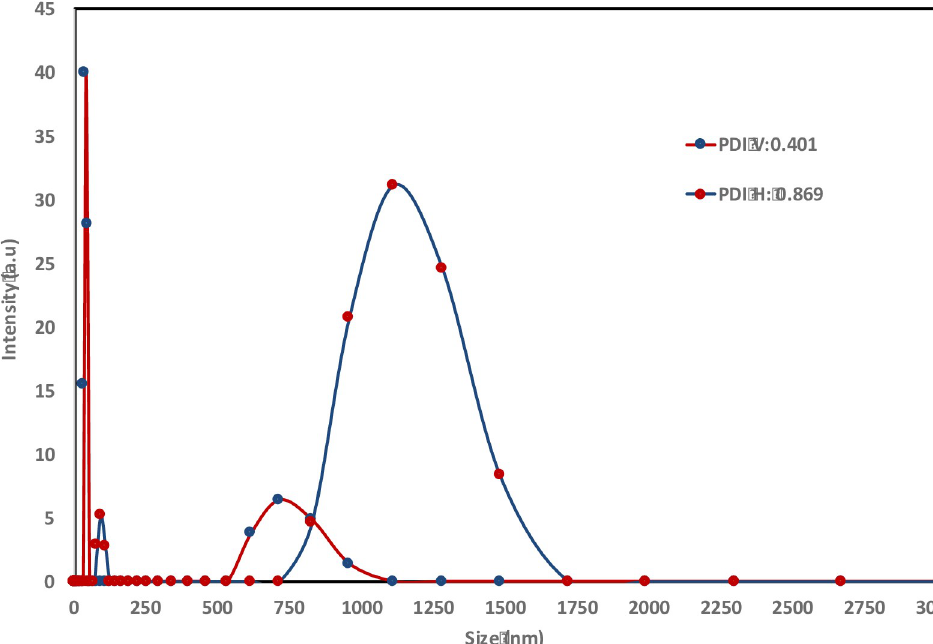
Fig 5. Dynamic light scattering (DLS) data (temperature: 25˚C; He-Ne laser: 633 nm; detector angle: 173˚) for encapsulated particles produced using vortex fluidic device (VFD) processing, using operating parameters in Fig 4 caption.